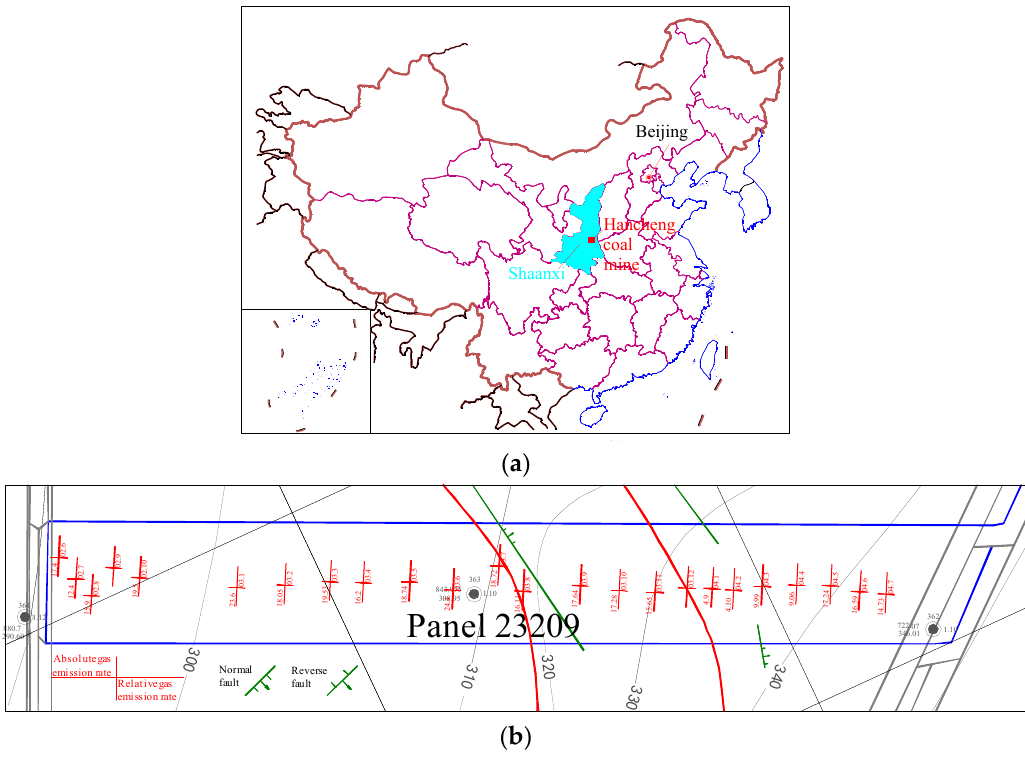
Figure 2. Location of the longwall panel LW23209, ( a ) location of Hancheng coal mine, ( b ) a plane view of the longwall panel LW23209.